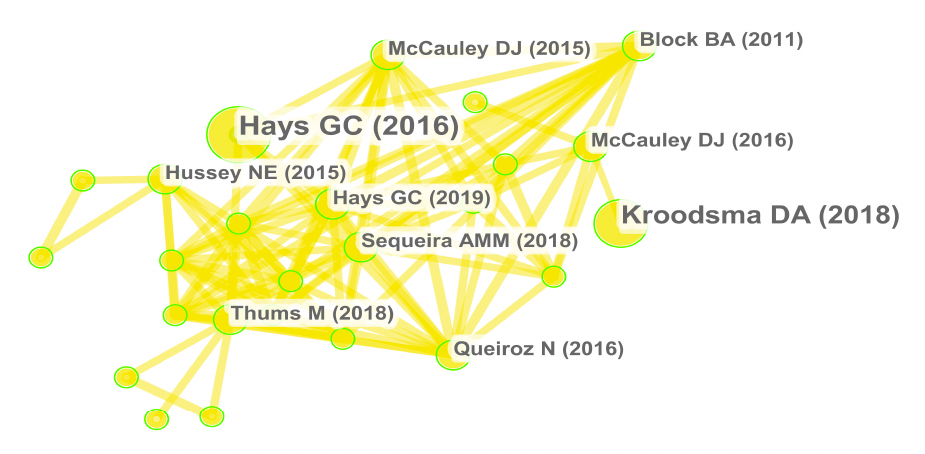
Figure 8. References co-citation network map. Table 6. Top 10 most cited references of big ocean data documents.